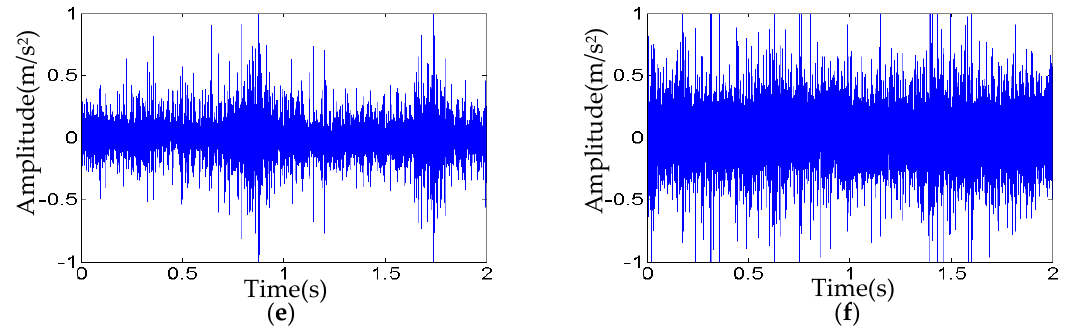
Figure 6. The simulation signals with six types of faults: ( a ) Fault type T 1 ; ( b ) Fault type T 2 ; ( c ) Fault type T 3 ; ( d ) Fault type T 4 ; ( e ) Fault type T 5 ; and ( f ) Fault type T 6 .